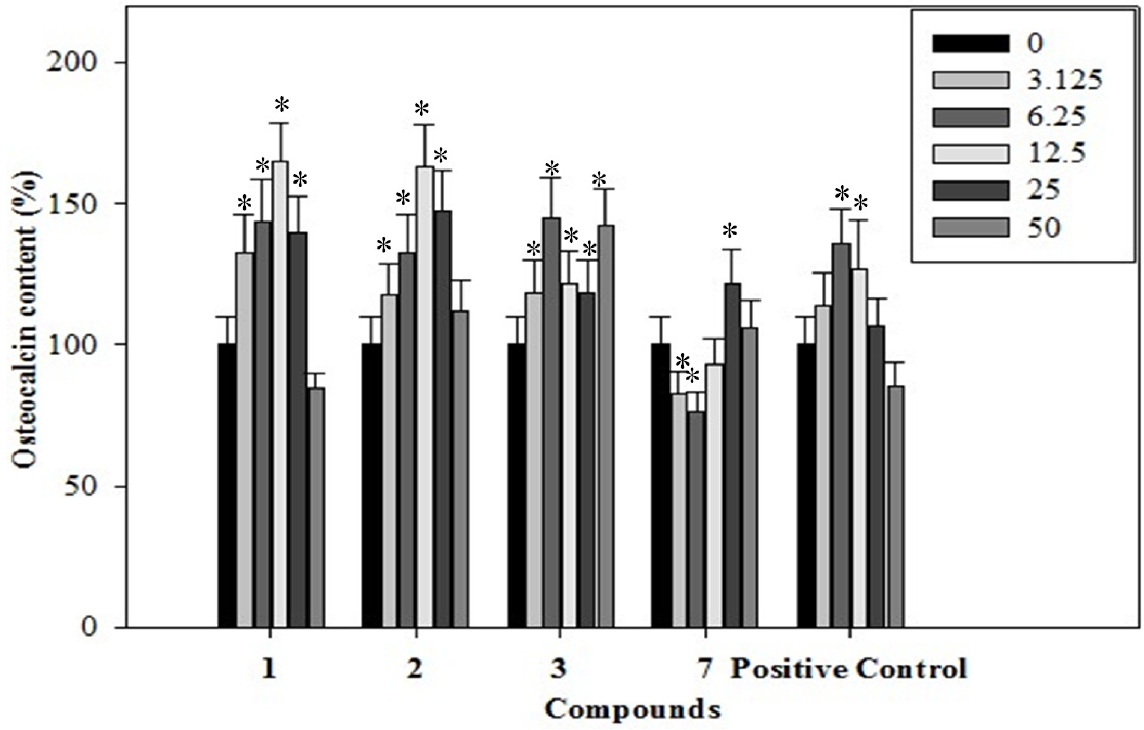
Figure 3. The effects of the phenolics ( 1 – 3 , 7 ) on osteocalcin content were assessed in rat osteoblast cells treated with the phenolics ( 1 – 3 , 7 ) (3.125–50 µg/mL) for 14